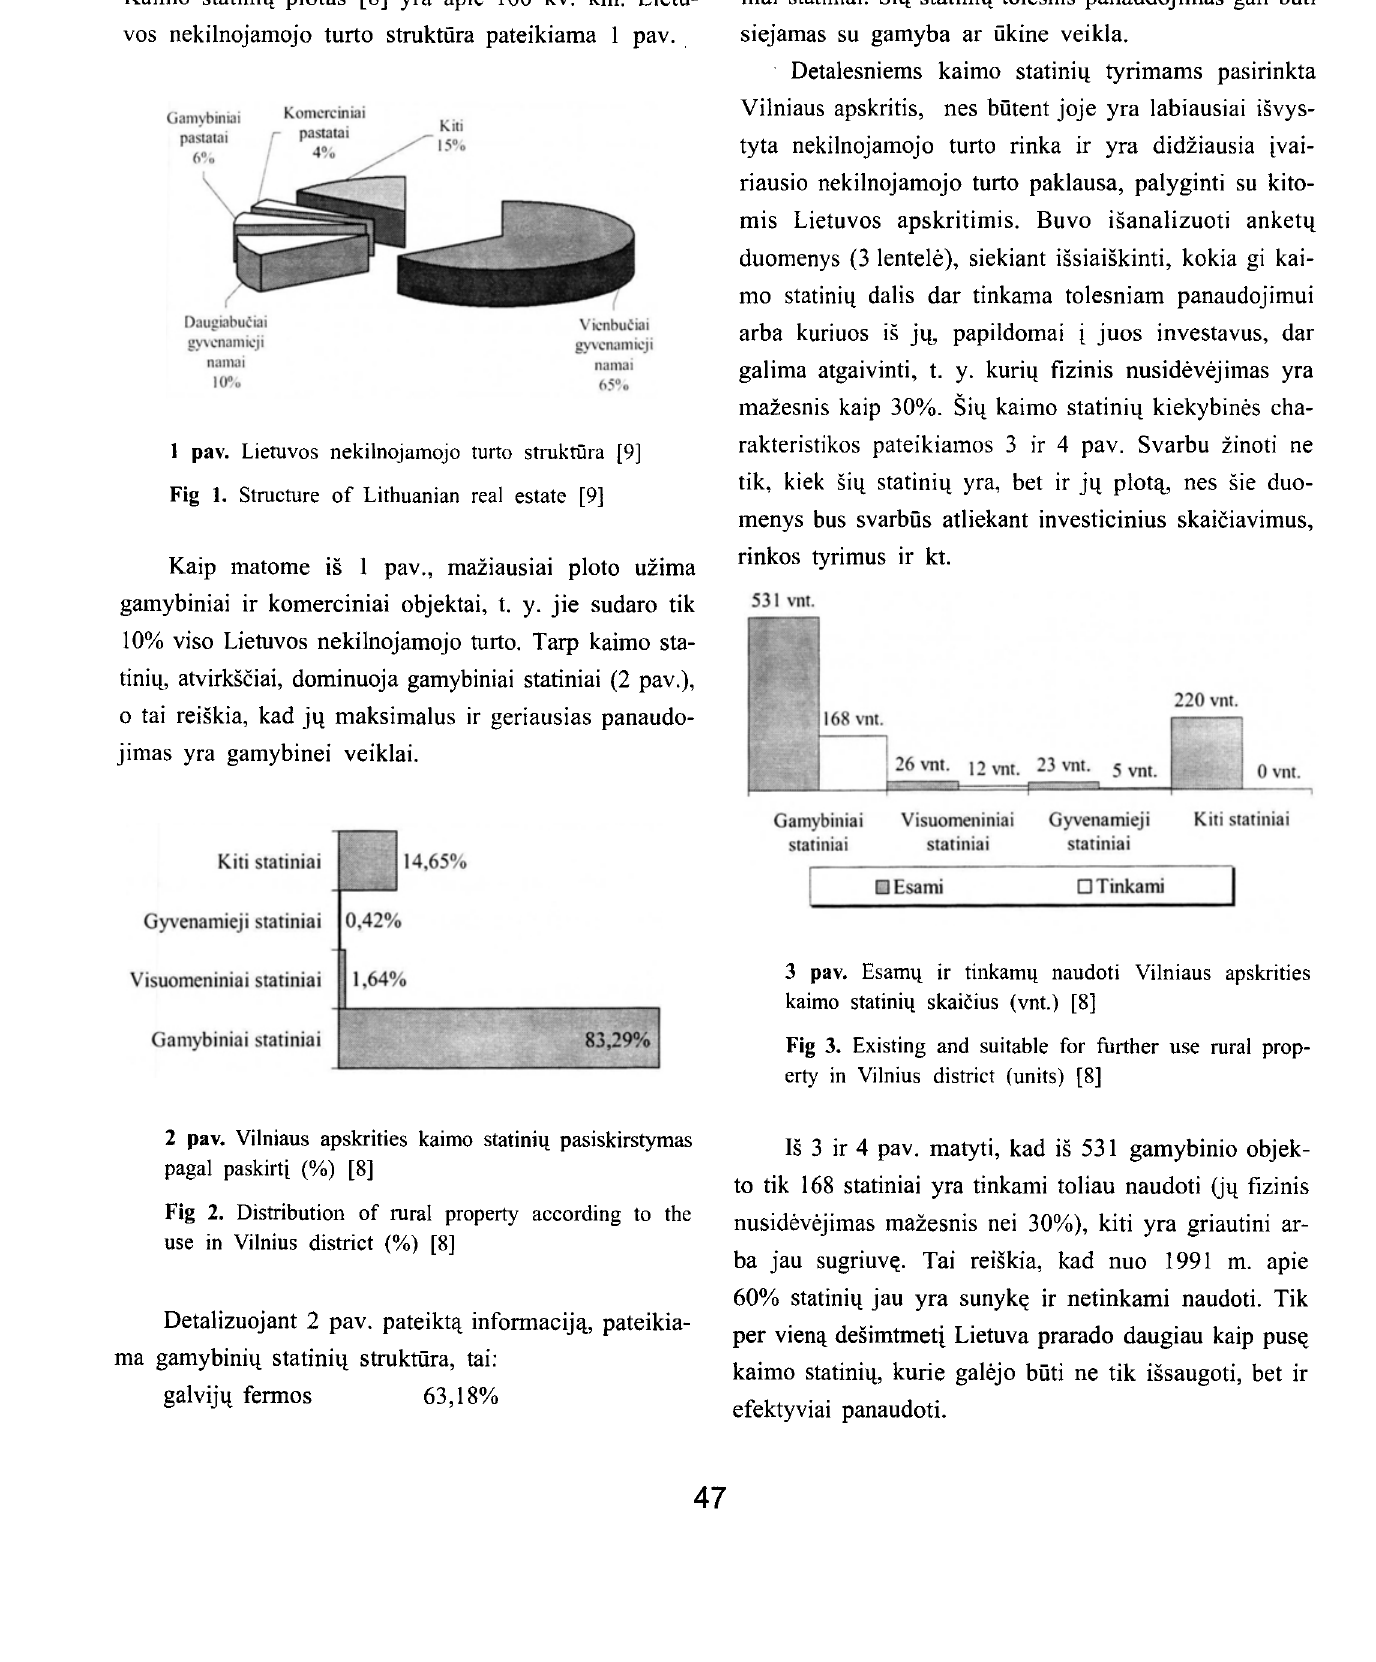
Fig I. Structure of Lithuanian real estate [9]